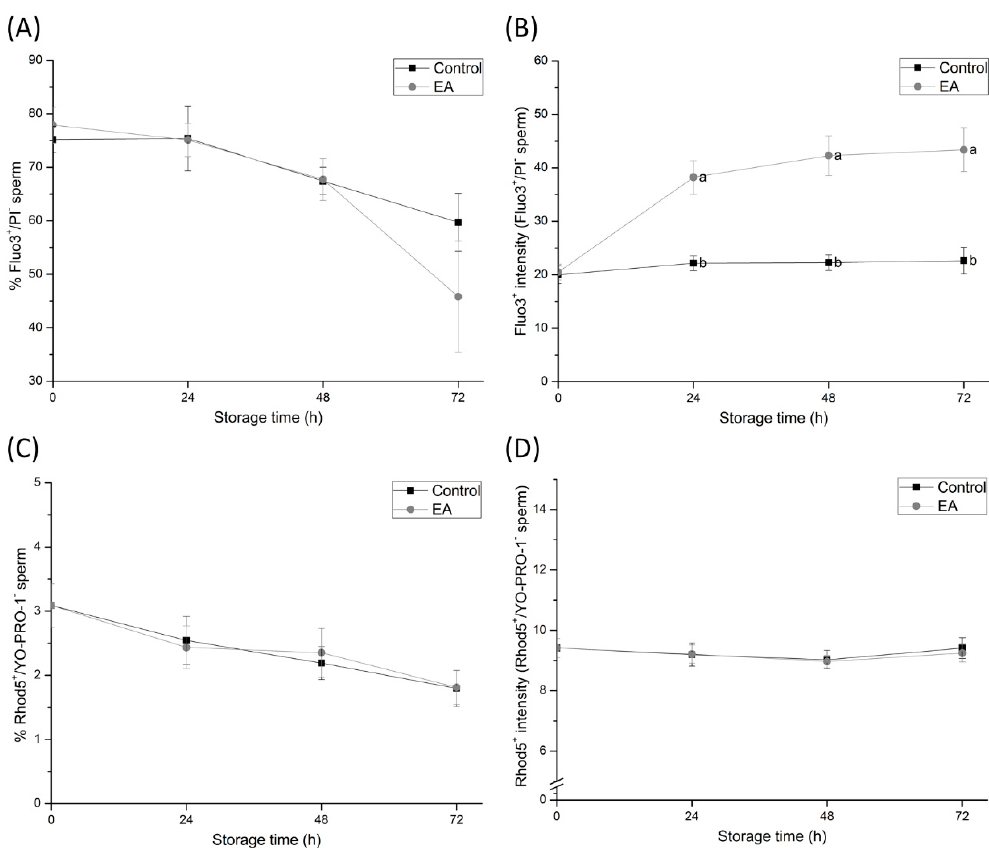
Figure 3. ( A ) Percentages of viable spermatozoa showing high intracellular calcium levels in the mid- piece and head (Fluo3 + /PI − ), ( B ) mean Fluo3 + fluorescence intensity of viable spermatozoa